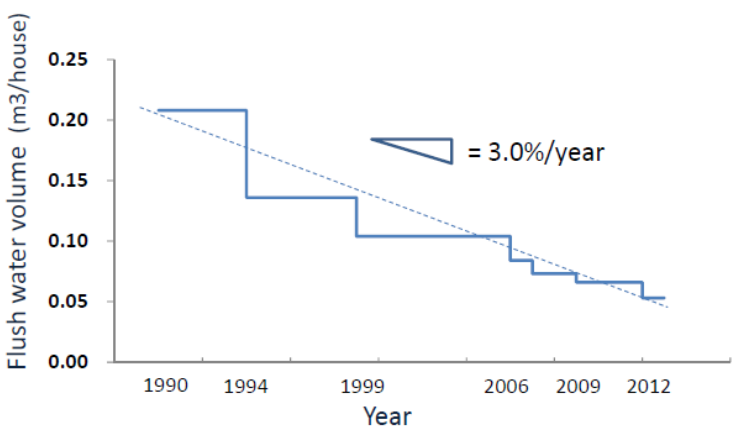
Figure 5. Eco-efficiency improvement rate α of toilet bowl.